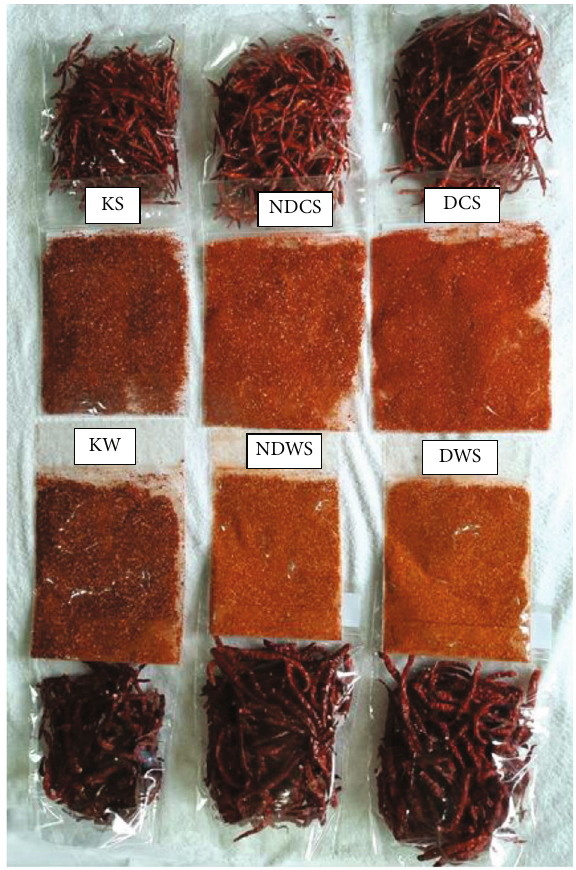
Figure 5: Comparison color of the dried chili product. DWS: whole pods dried using desiccant in solar drying; NDWS: whole pods dried without using desiccant in solar drying; KW: whole pods dried using natural convection solar drying; DCS: half chili pods dried using desiccant in solar drying; NDCS: half chili pods without using desiccant in solar drying; KC: half chili pods dried using natural convection solar